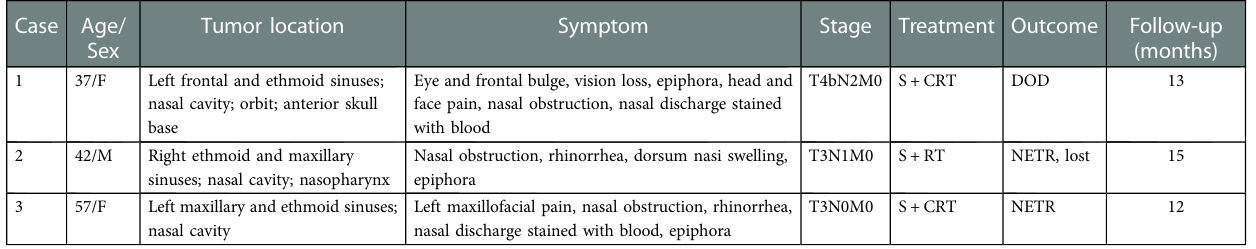
TABLE 1 Clinical characteristics of patients with sinonasal NUT carcinoma.